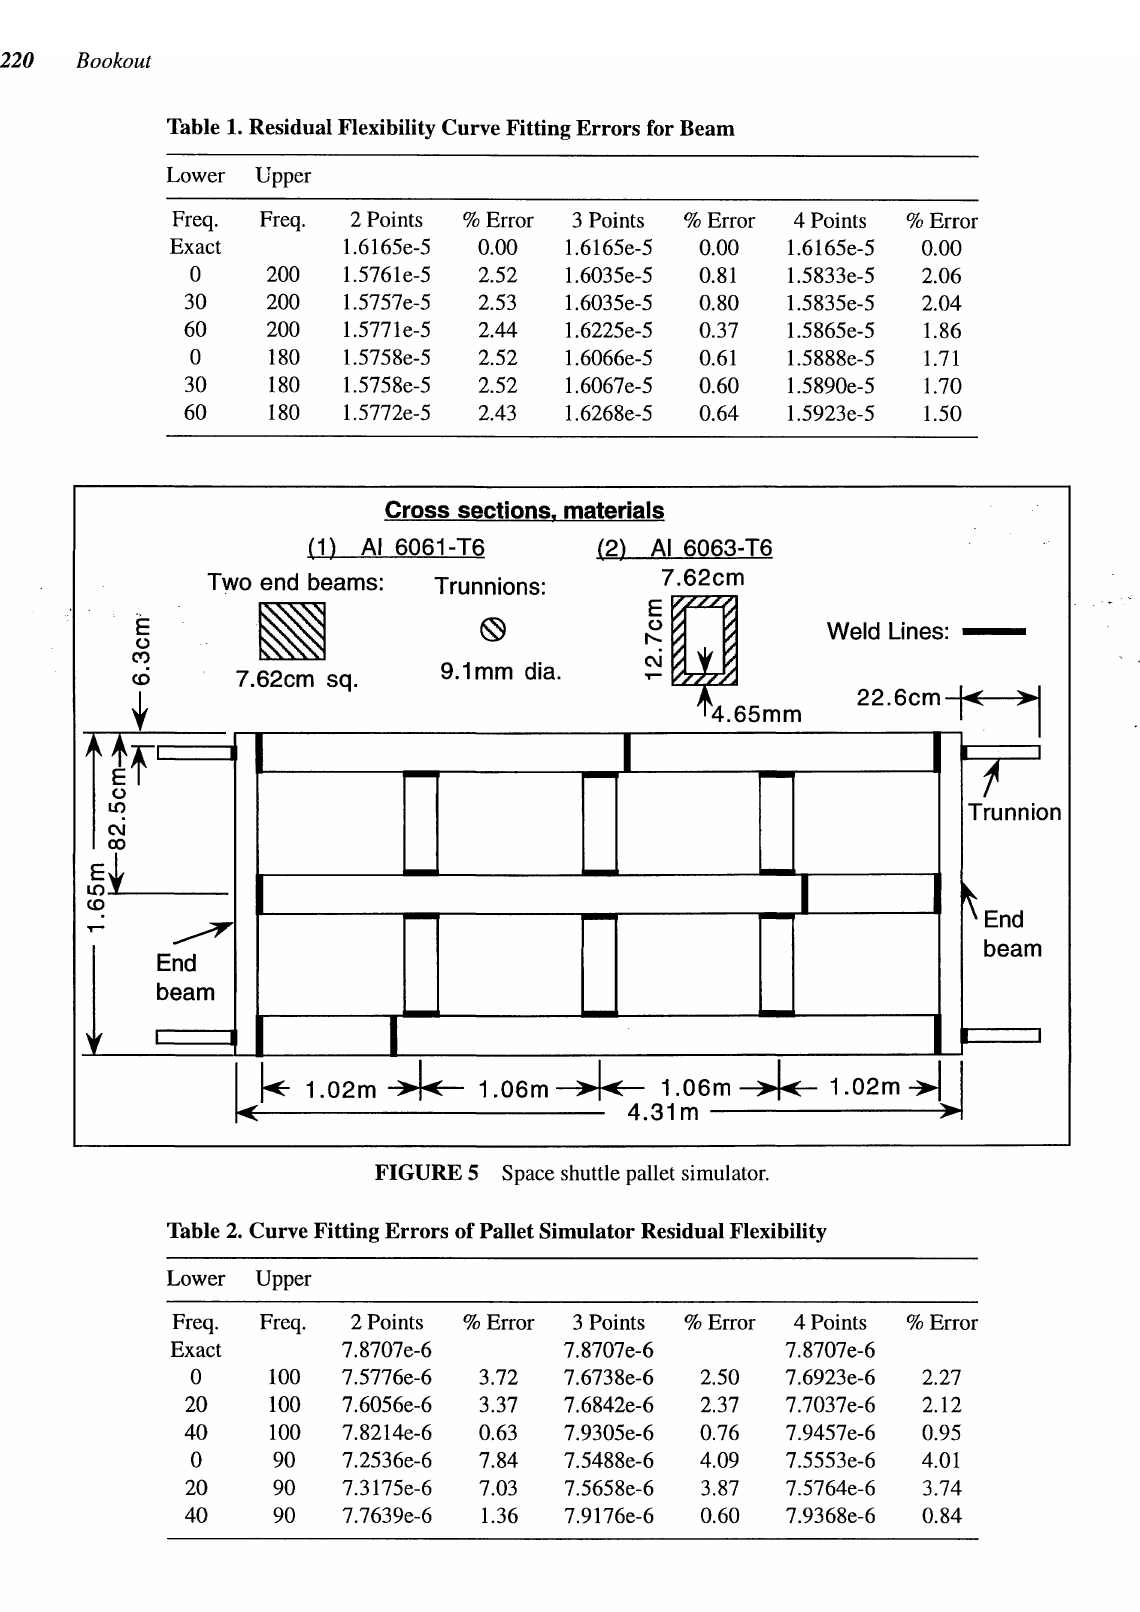
Table 2. Curve Fitting Errors of Pallet Simulator Residual